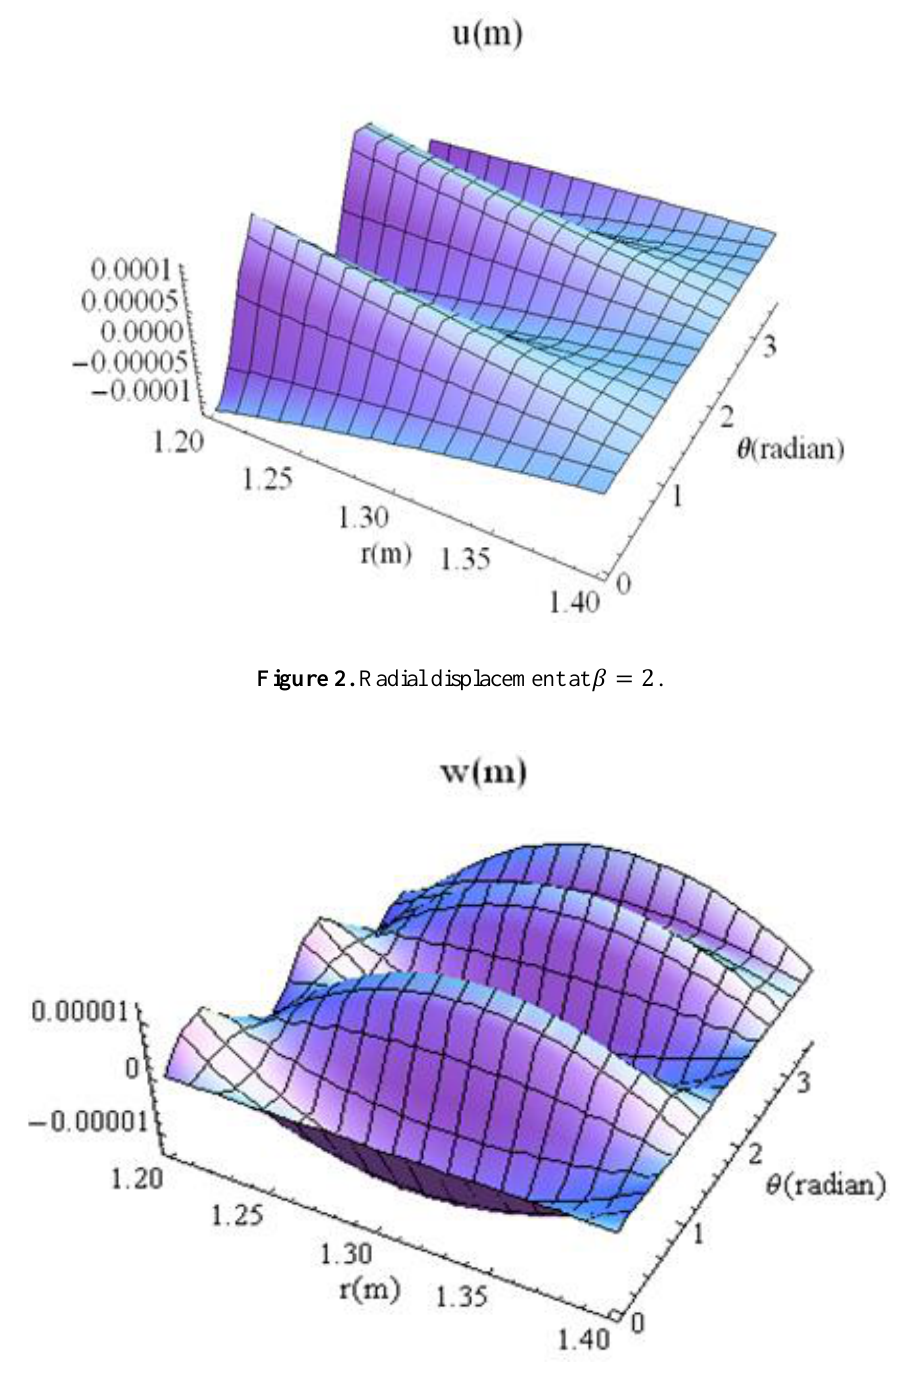
Figure 3. Circumferential displacement at 𝛽 = 2